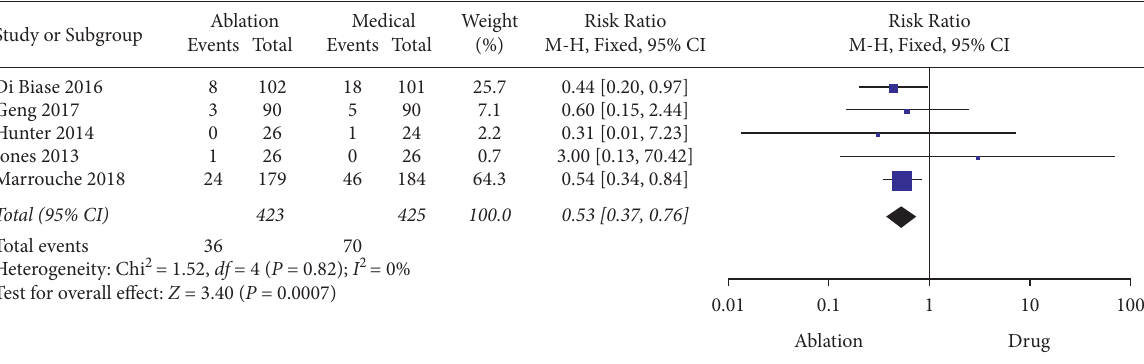
Figure 7: Forest plot of CA versus medical therapy: all-cause mortality.